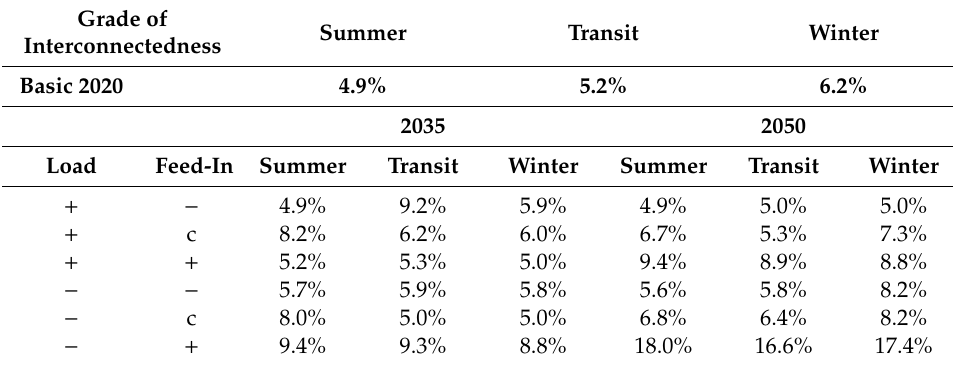
Table 8. Grade of interconnected GoI p